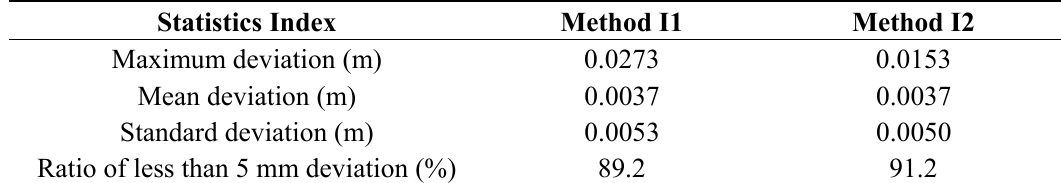
Table 4. Accuracy of the integrated RTK-GPS/accelerometer calculation according to method.